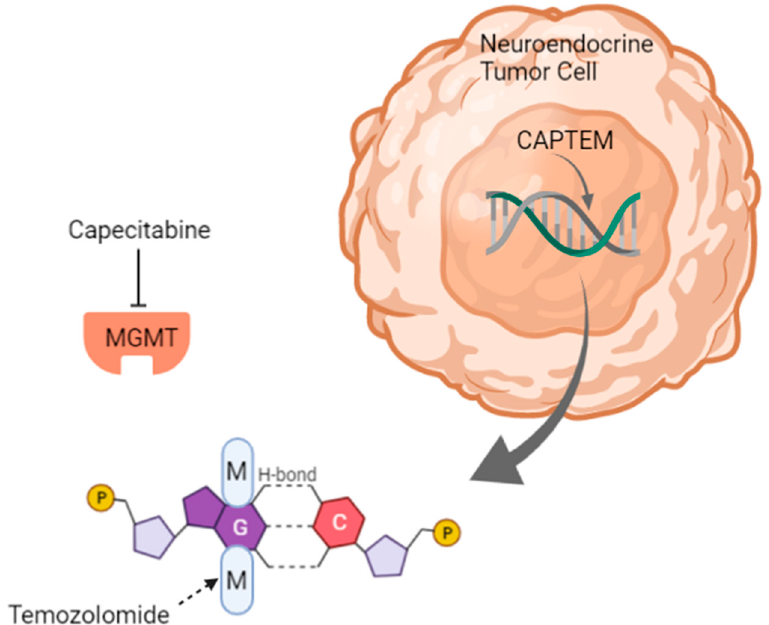
Figure 1. A depiction of the mechanism of action of capecitabine plus temozolomide in a neuroen- docrine tumor. Temozolomide adds a methyl group to the O 6 position of guanine, resulting in mismatched bases and cell death. The MGMT enzyme typically transfers methyl groups from the O 6 position of guanine to its cysteine residue; however, this is inhibited by capecitabine. The figure was created in Biorender. Abbreviations: M, methyl group; CAPTEM, capecitabine plus temozolomide; G, guanine; C, cytosine.